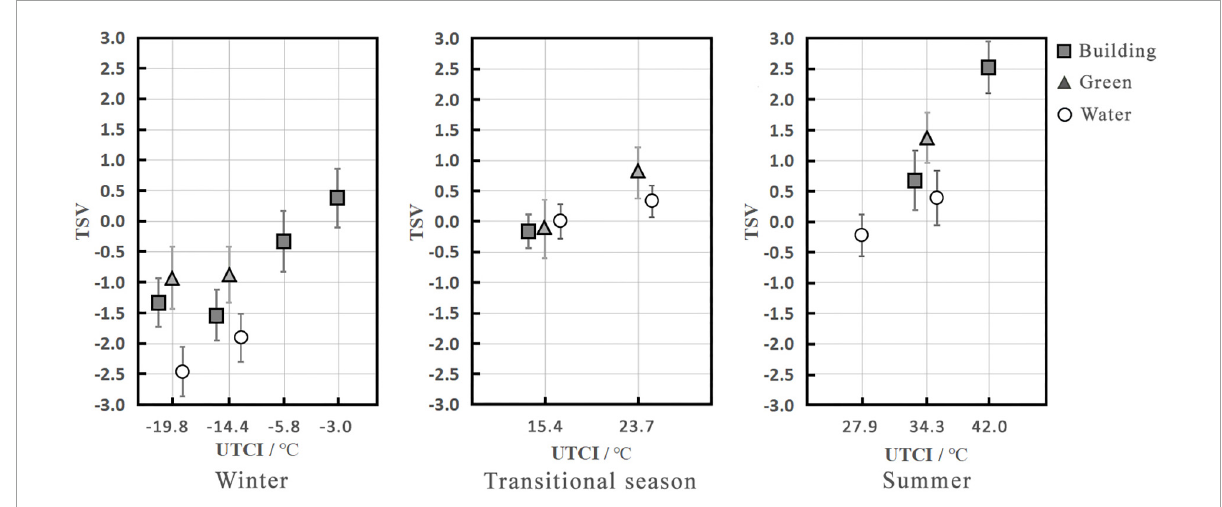
FIGURE3 Mean TSV under different thermal stress levels and visual landscapes (abscissa is the categorical